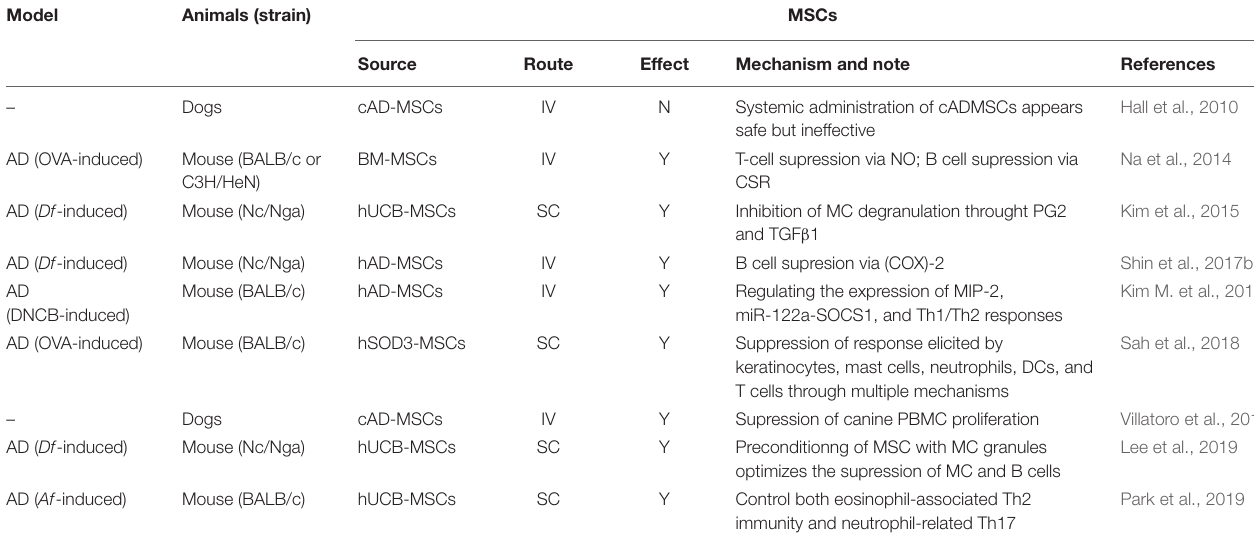
TABLE 1 | Effect of MSCs on experimental animal models of atopic dermatitis.